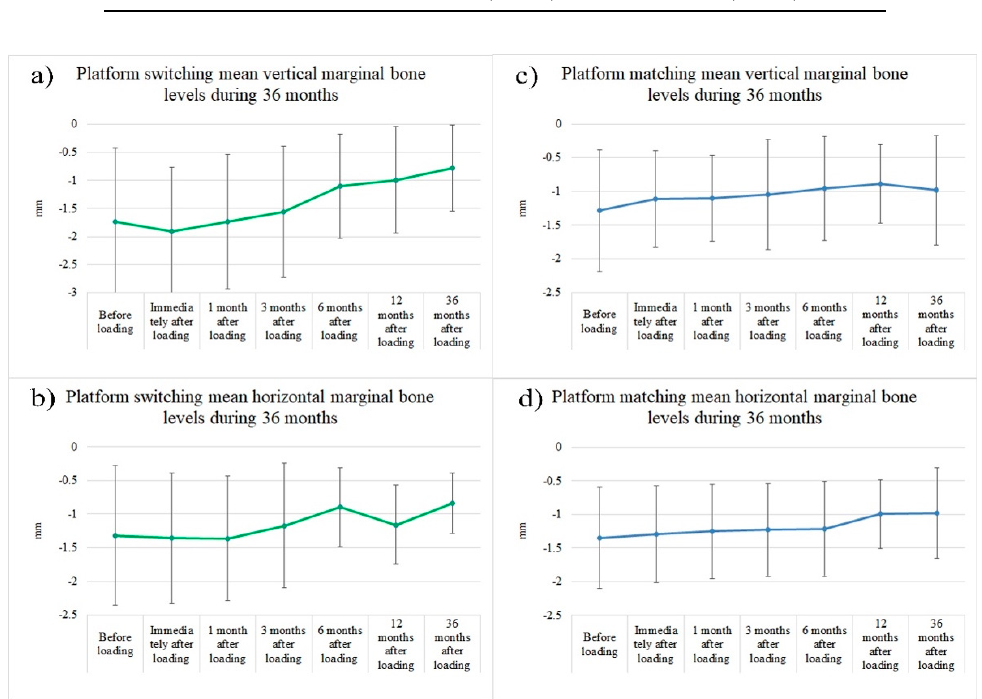
Figure 4. Measurements for mean vertical and horizontal marginal bone loss over the 36-month follow-up period. Variations in the mean vertical and horizontal marginal bone loss before and up to 36 months after loading. ( a ) The mean vertical marginal bone loss measurements over the 36-month period for PS implants. ( b ) The mean horizontal marginal bone loss measurements over the 36-month period for PS implants. ( c ) The mean vertical marginal bone loss measurements over the 36-month period for PM implants. ( d ) The mean horizontal marginal bone loss measurements over the 36-month period for PM implants. Table 2. Marginal bone level for PS and PM implants at different time points (mean ± SD mm).